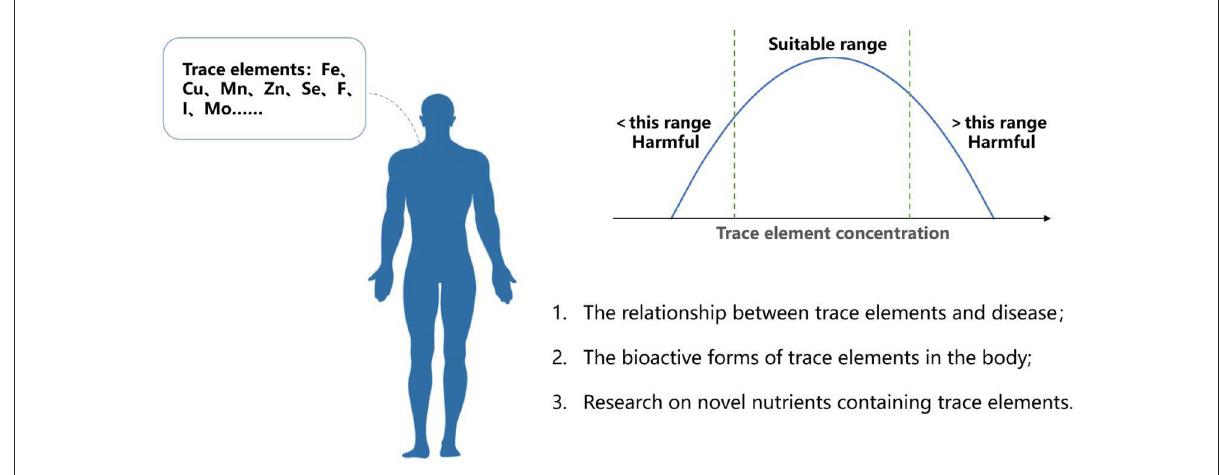
FIGURE1 Trace elements in human nutrition and